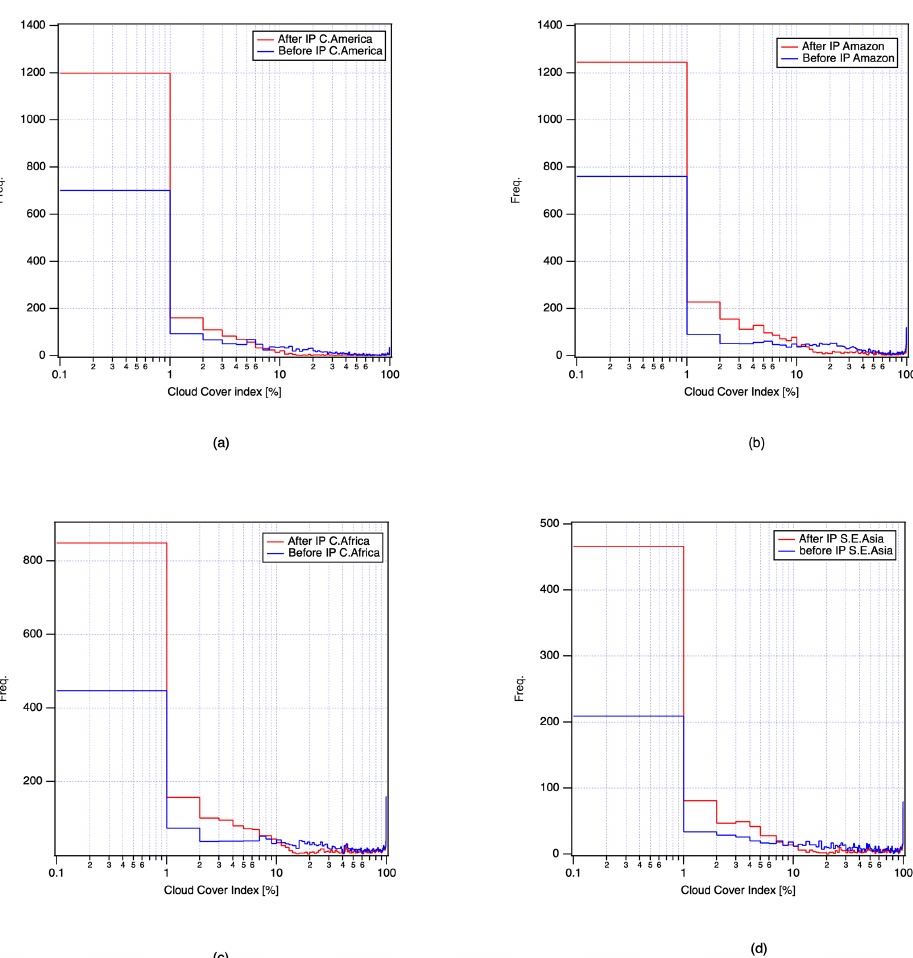
Figure 20. Histograms of cloud cover index before and after intelligent pointing for selected regions defined in the text (1% bins): (a) central America, (b) Amazon, (c) central Africa, and (d) southeast Asia.